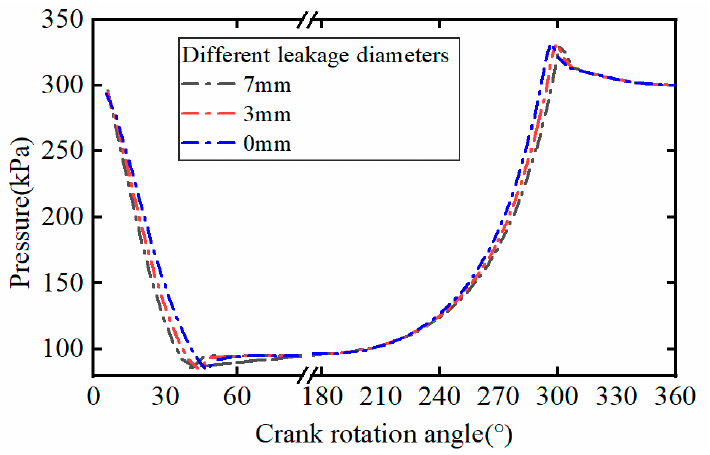
Figure 13. The cylinder pressure with different diameter leakage hole under full load condition.